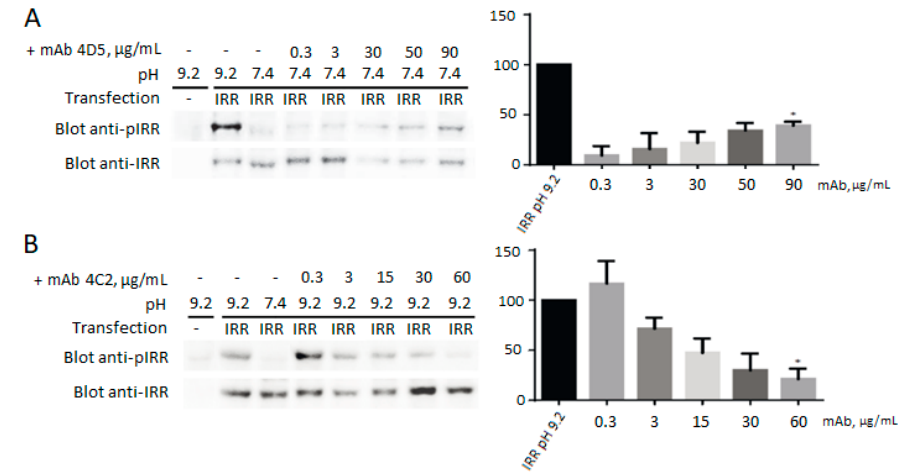
Figure 2. Activation and inhibition of IRR by monoclonal antibodies. For each antibody the IRR phosphorylation level at pH 9.2 is indicated as 100%. Transfected cells were incubated with different concentrations of antibodies from 0.3 to 90 µg/mL. Lysates of transfected cells were directly analyzed by Western blotting with anti-pIRR antibodies and after stripping with anti-IRR antibodies. For the quantitative analysis of Western blots, we used Fusion Solo system (Vilber Lourmat, Coll é gien, France). The ratio of integral density of the phosphorylated receptor (pIRR signal) to the total receptor (IRR antibody signal) was plotted versus antibody concentration. Values are means ± SE ( n ≥ 4). Asterisks indicate p < 0.05. ( A ) Incubation of the IRR-expressing HEK293 cells with 4D5 antibodies at рН 7.4 leads to IRR phosphorylation. ( B ) Incubation of the IRR-expressing HEK293 cells with 4C2 antibodies at рН 9.2 leads to the inhibition of the IRR activation by